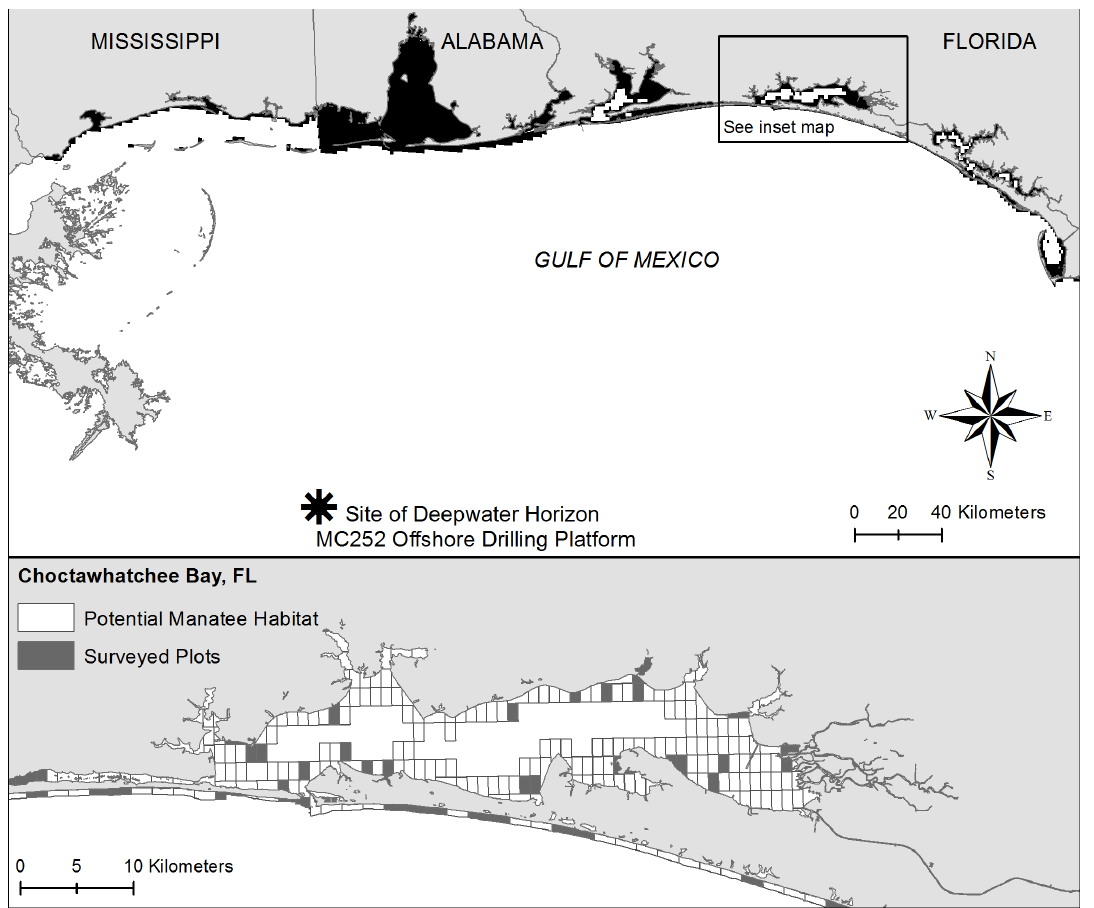
Figure 1. Areas surveyed in helicopters to obtain the upper estimate of the number of manatees in areas potentially affected by the Deepwater Horizon oil spill.